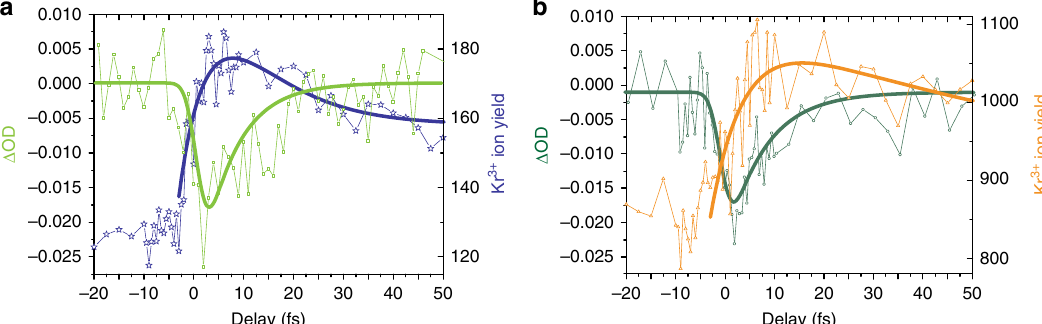
Fig. 3 Absorbance change Δ OD and Kr 3+ ion yield vs. time delay. The change in absorbance or optical density Δ OD states the difference of the optical density OD = − log 10 ( I t ( Δ t )/ I 0 ) at a given time delay Δ t ( I t ( Δ t ) is the transmitted signal at time delay Δ t , I 0 is the reference intensity measured at a time delay t R = − 30 fs). a At lower NIR intensities of (8.6 ± 1) × 10 13 W cm − 2 , the absorbance (light green, left scale) transiently drops around pulse overlap, while the Kr 3+ ion yield (blue, right scale) shortly rises before it settles to an elevated ion yield of almost 160 counts in 20 s integration time. b At a NIR intensity three times as high, (2.9 ± 0.5) × 10 14 W cm − 2 , the absorbance (dark green, left scale) transiently drops around pulse overlap similar to a , while the Kr 3+ ion yield (orange, right scale) shortly rises before it settles to an elevated ion yield of about 860 counts in 20 s integration time with a slower decay constant when compared to a . Please see Supplementary Note 2 for longer